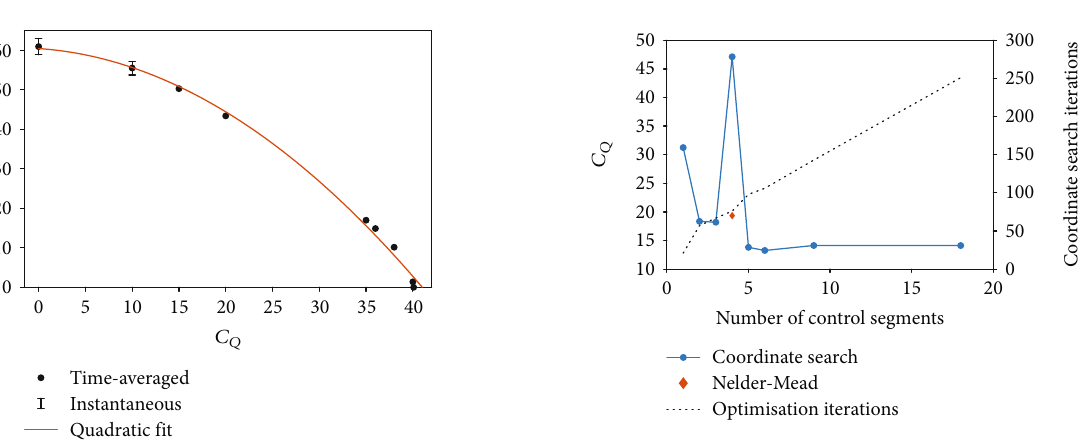
Figure 6: E ff ect of uniform suction strength on the angle of separation at Re = 80 . Where vortex shedding occurs, the maximum and minimum θ s is shown with error bars.